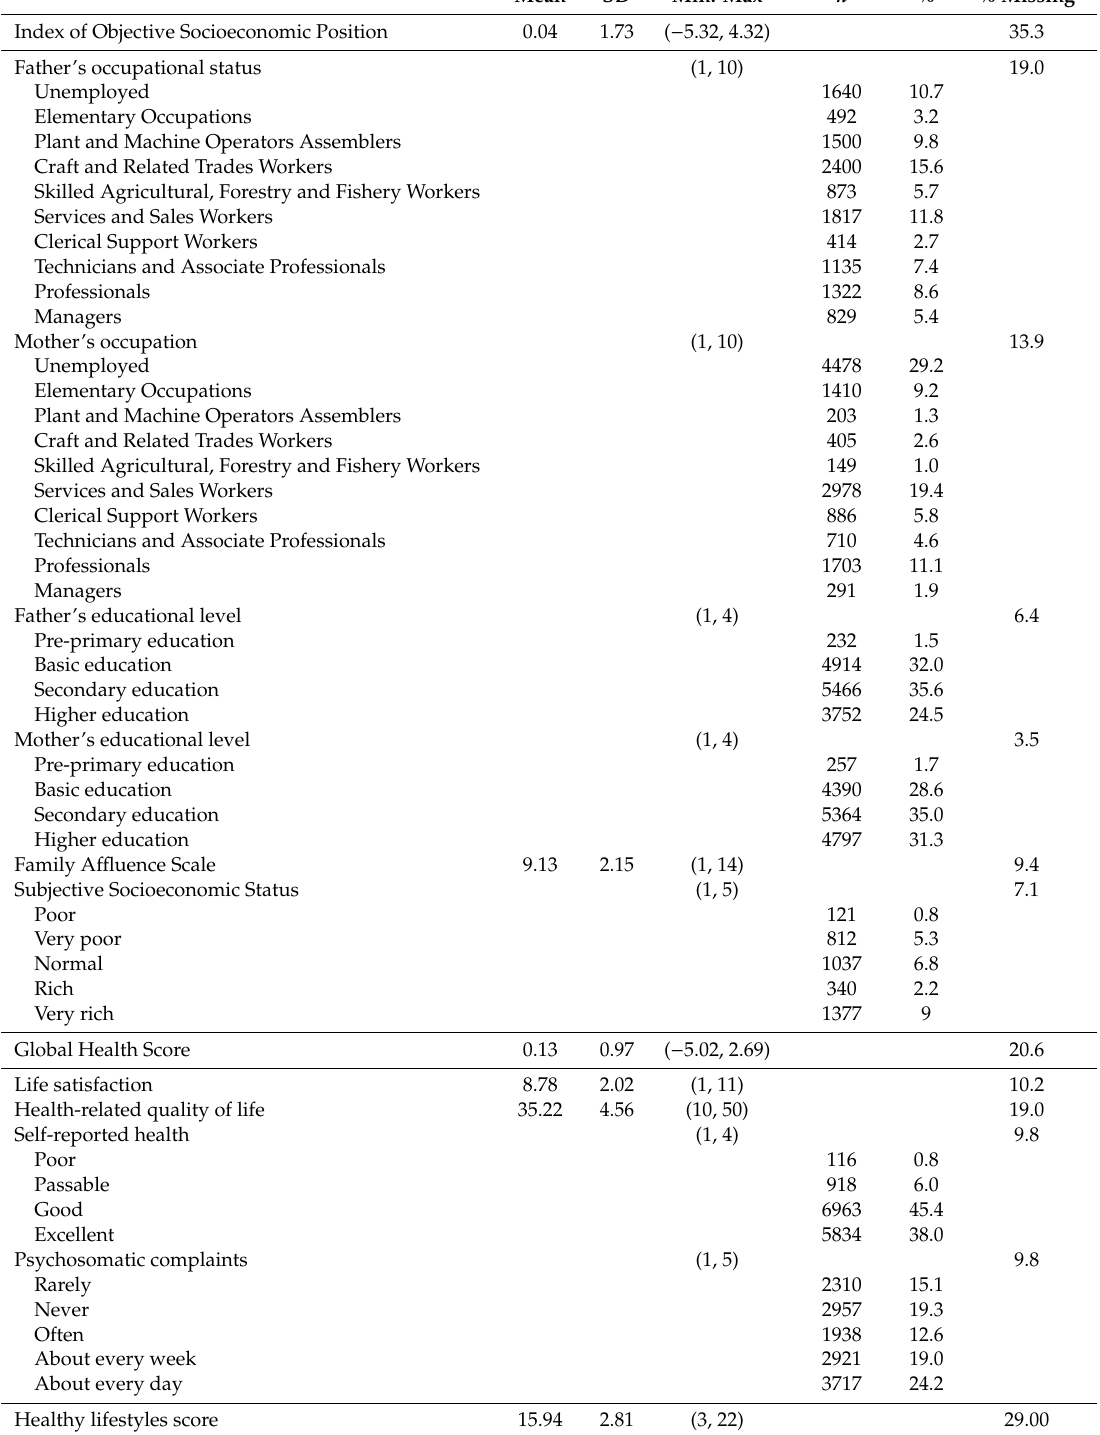
Table 2. Descriptive characteristics of the sample population in all variables analyzed ( n = 15,340 adolescents aged 11–16 years